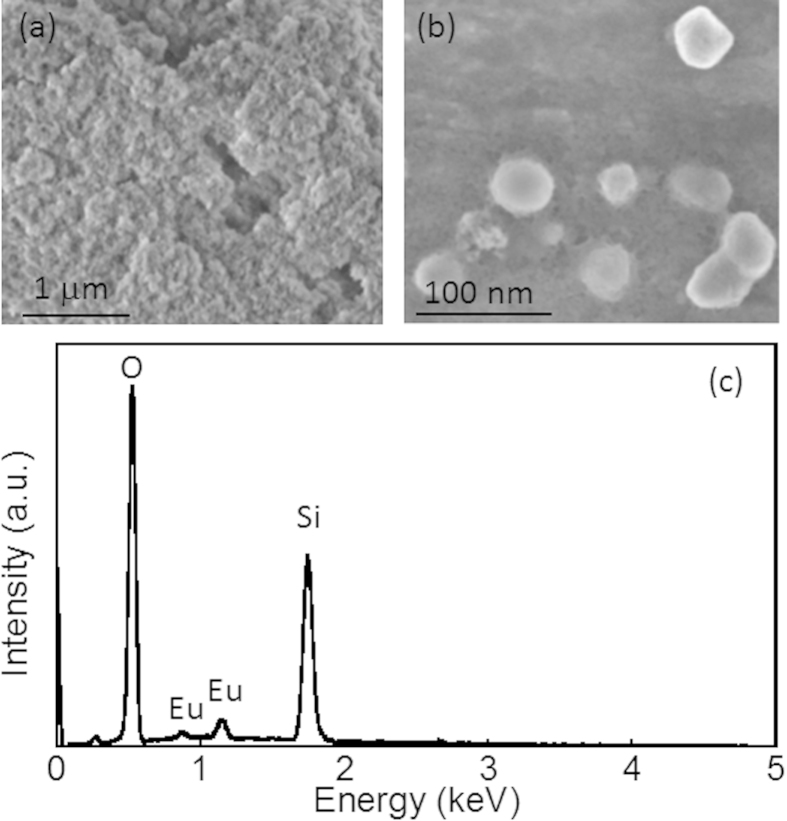
a) Low and b) high magnification SEM images of SiO2/Eu nanoparticles and c) the EDS pattern obtained from SiO2/Eu nanoparticles.